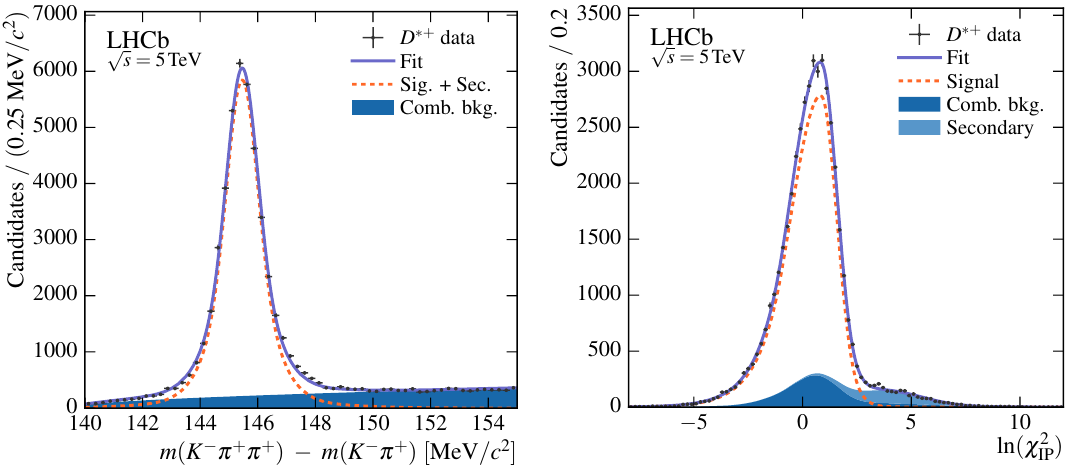
Figure 4. Distributions for selected D (cid:3) + (cid:1) m = m ( D (cid:3) + ) m ( D 0 ) for a mass window of (cid:0) (cid:0) (cid:1) ln (cid:31) 2 of the D 0 with an additional mass window of IP di(cid:11)erence. The sum of the simultaneous likelihood (cid:12)ts in each ( p T ; y ) bin is shown, with components as indicated in the